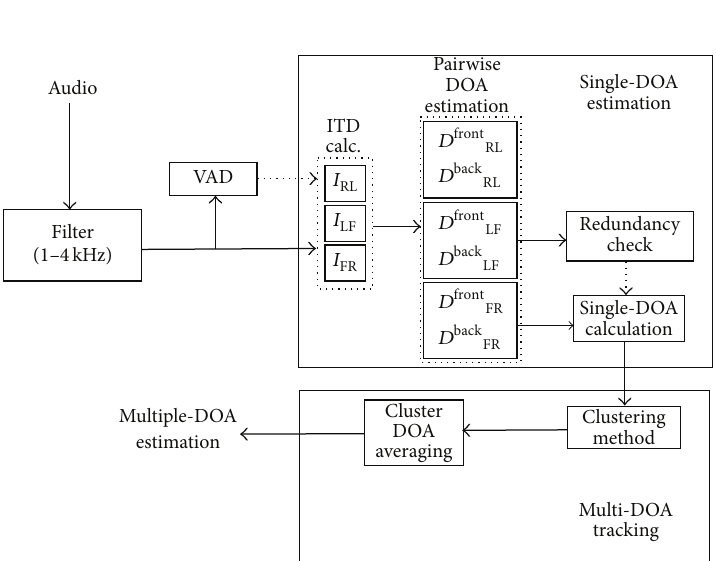
Figure 3: Architecture of the multiple-DOA estimation